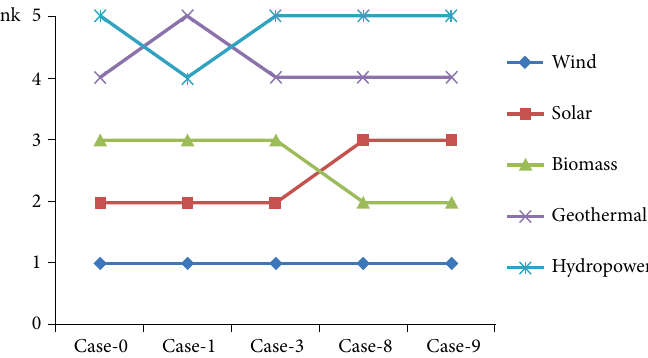
Fig. 7. The ranking of renewable energy alternatives based on sensitivity